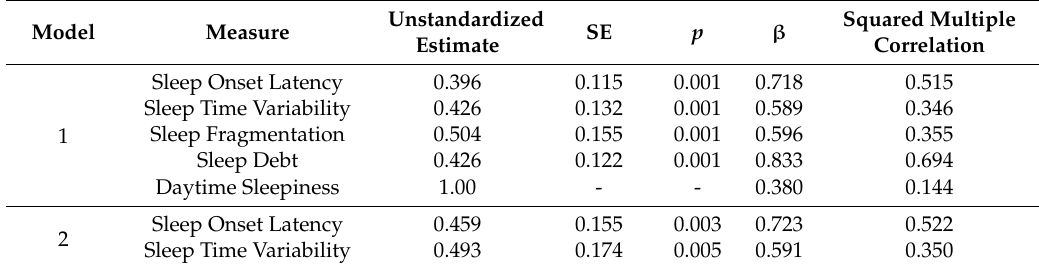
Table 7. Factor loadings and squared multiple